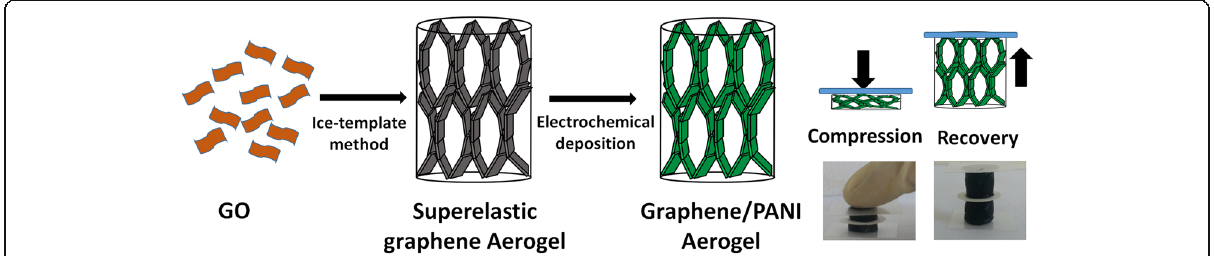
Fig. 1 Illustration for the fabrication process of compressible graphene/PANI aerogel